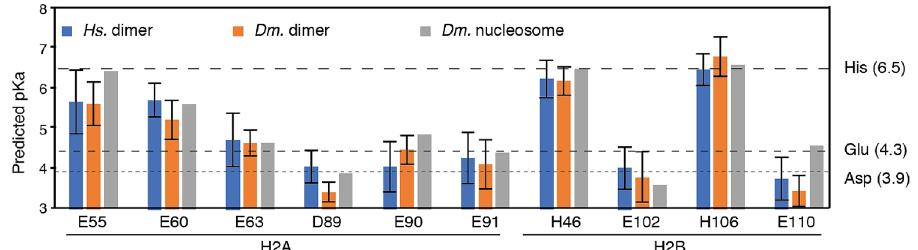
Figure 2. Elevated predicted pKa for acidic patch residues in the free H2A-H2B dimer and the nucleosome. Predicted pKa values for acidic patch residues and the two H2B His that line the acidic patch using PROPKA for the solution structures of the Dm . H2A-H2B dimer determined here and the and Hs . dimer (PDB-id 2RVQ) and the nucleosome crystal structure (PDB-id 2PYO). For the solution structures, the average value and standard deviations across all ensemble members are plotted. The reference pKa values for free Asp, Glu and His side chains are indicated as dashed